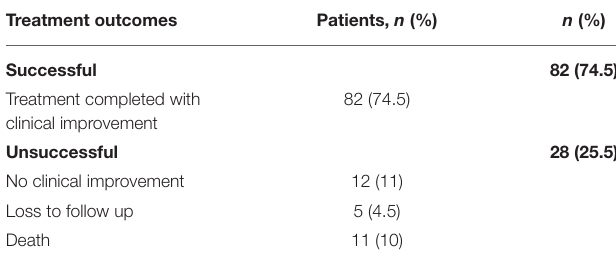
TABLE 4 | Modification in antibiotic therapy based on clinician’s suggestion and culture and sensitivity results ( N = 110).